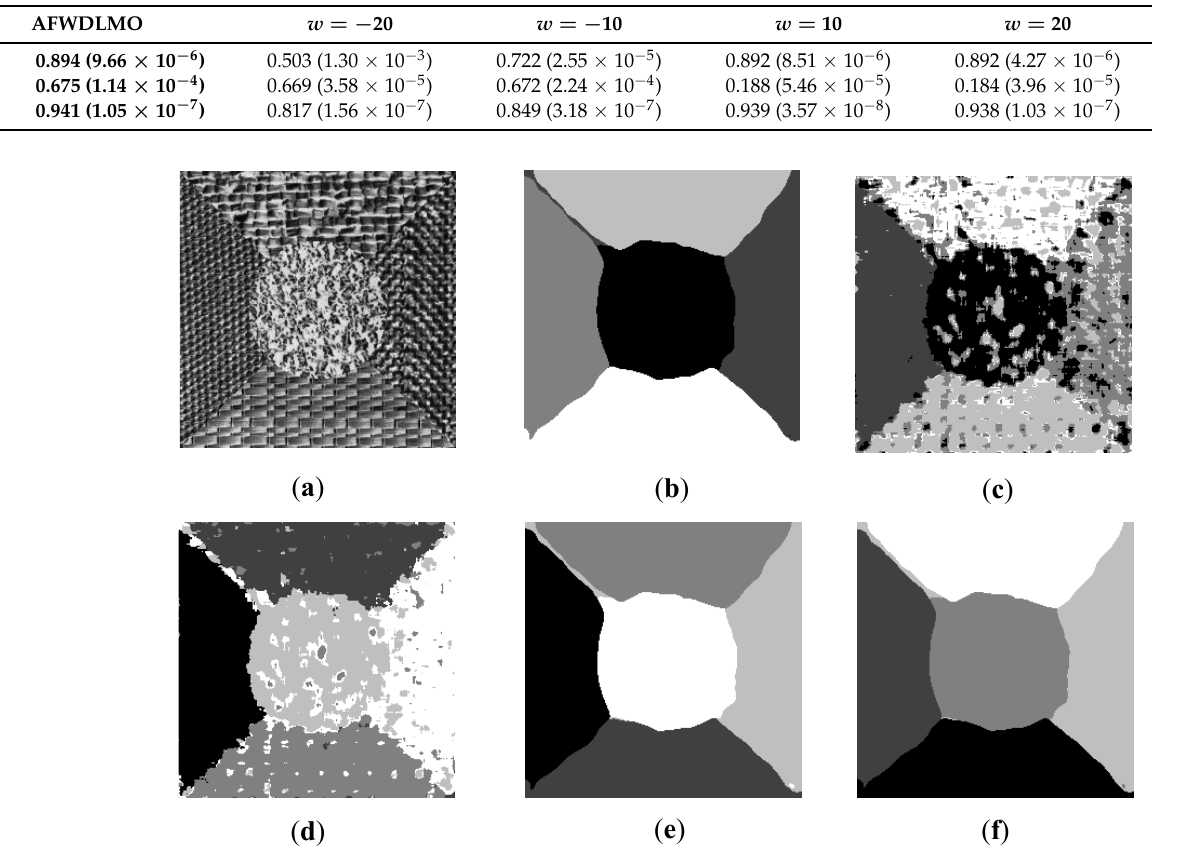
Figure 18. Segmentation results of five different feature weights on Image1. ( a ) original image; ( b ) the weight of weight determination layer; ( c ) w = − 20; ( d ) w = − 10; ( e ) w = 10; ( f ) w =